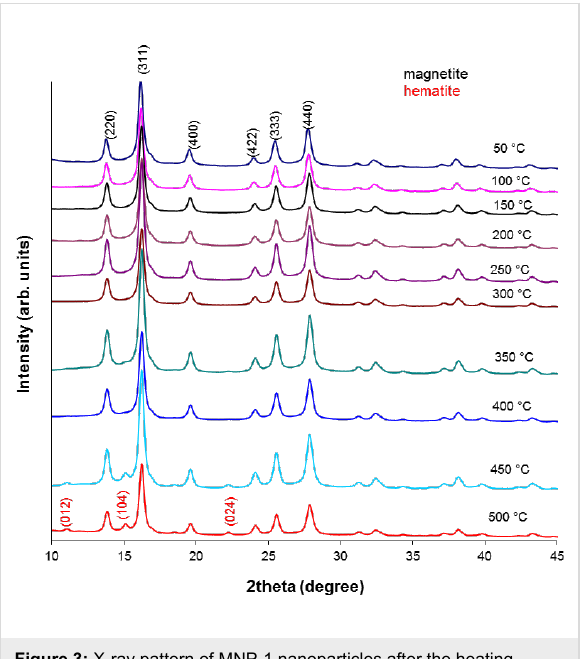
Figure 3: X-ray pattern of MNP-1 nanoparticles after the heating process.